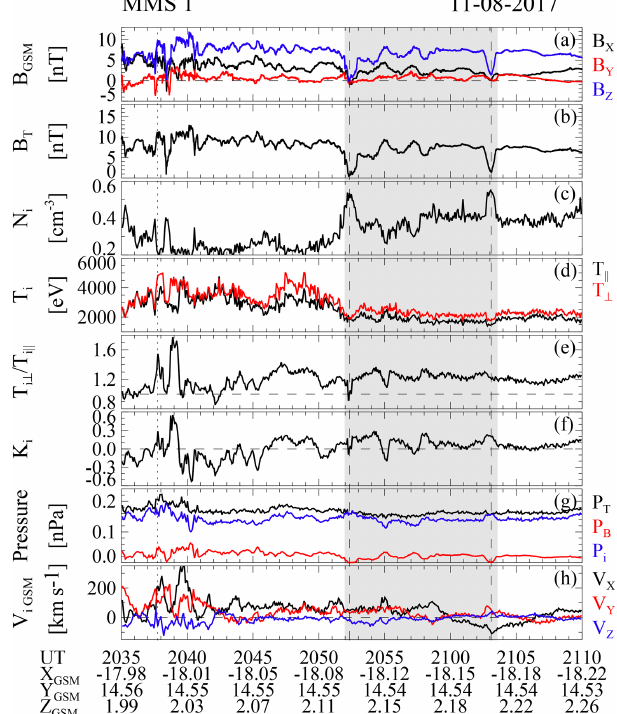
Figure 1. Observations of a DF event by MMS1 on 11 August 2017. From top to bottom: three components of the magnetic field in GSM (a) , the total magnetic field (b) , ion density (c) , ion perpendicular (red) and parallel (black) temperatures (d) , ion perpendicular tem- perature anisotropy (e) , the threshold of the mirror instability (f) , the magnetic, ion thermal, and total pressures (g) , and three com- ponents of the ion velocity in GSM (h) . The gray shadow indicates several compressional structures. The vertical dotted line indicates the DF, and the dashed lines indicate the trough of two hole-like